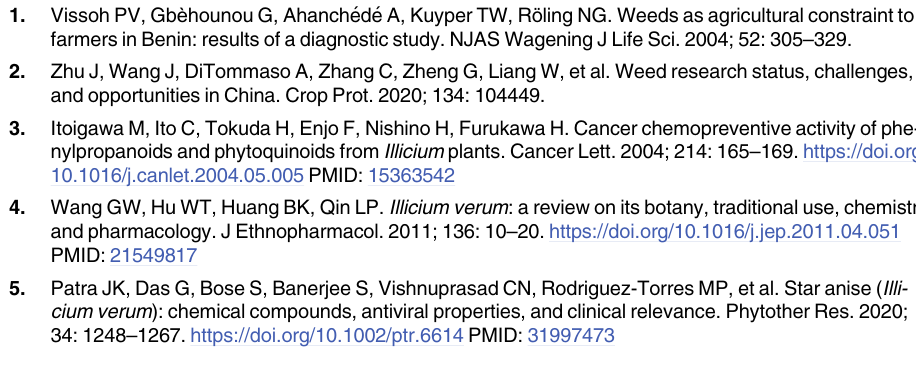
S1 Table. Proportions of soil dominant bacterial communities at genus level between the NW and MW treatments in star anise plantations (%). S2 Table. Proportions of soil dominant fungal communities at genus level between the NW and MW treatments in star anise plantations